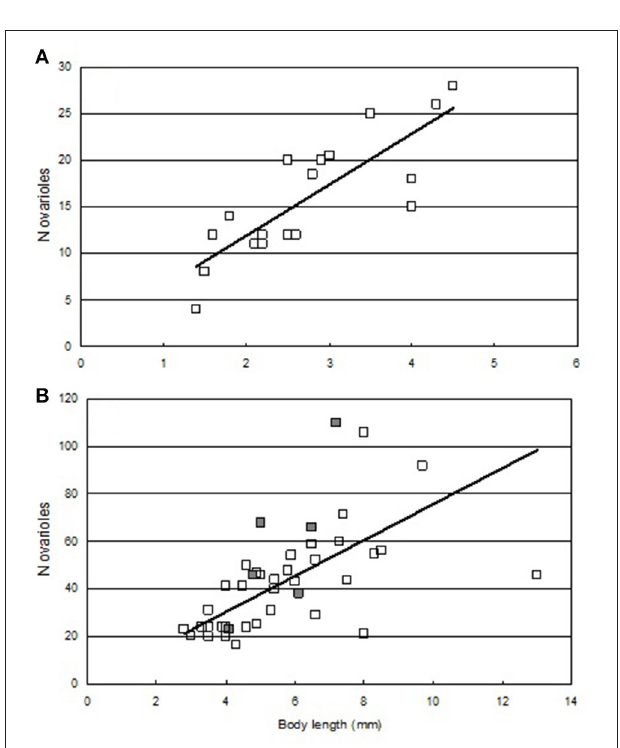
FIGURE 4 | Body-length (mm) and average number of ovarioles in species (A) feeding on non-aphid prey ( N = 18, R = 0.821, a = 0.900, b = 5.482, P < 0.001) and species (B) feeding on aphids ( N = 40, R = 0.567, a = 8.521, b = 6.203, P < 0.001). Dark symbols: species that invaded the Nearctic from the Palearctic. Data from Nedvˇed and Honˇek